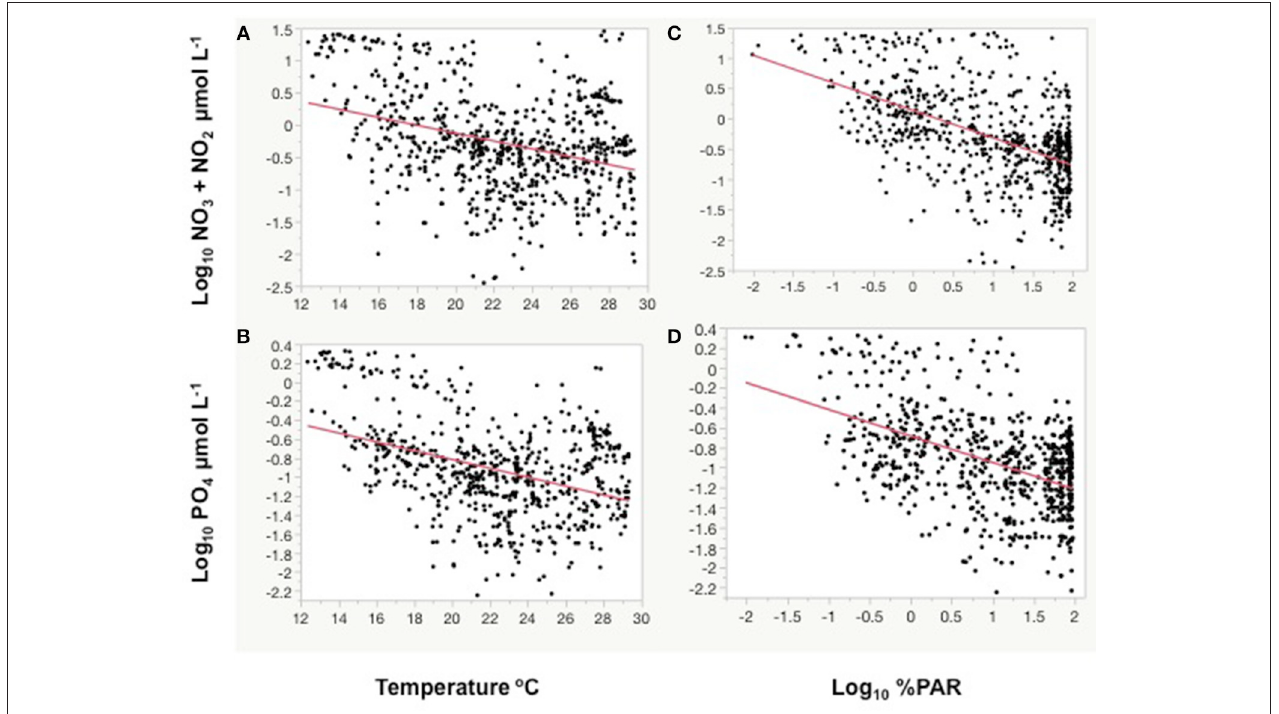
FIGURE 5 | The relationships between (A) log 10 NO 3 + NO 2 concentration and (B) log 10 PO 4 concentrations with temperature, and, between (C) log 10 NO 3 + NO 2 concentration and (D) log 10 PO 4 concentrations and the log 10 %PAR at depth observed during the Malaspina expedition. Red lines represent the linear fits. (A) Linear fitted equation, log NO 3 + NO 2 = 1.10 – 0.062*Temperature ( ◦ C), r 2 = 0.12, P < 0.0001. (B) Linear fitted equation, log PO 4 = 0.12 – 0.046*Temperature ( ◦ C), r 2 = 0.16, P < 0.0001. (C) Linear fitted equation, log NO 3 + NO 2 = 0.135 – 0.45*log %PAR, r 2 = 0.29, P < 0.0001. (D) Linear fitted equation, log PO 4 = − 0.68 – 0.266*log %PAR, r 2 = 0.24, P < 0.0001.